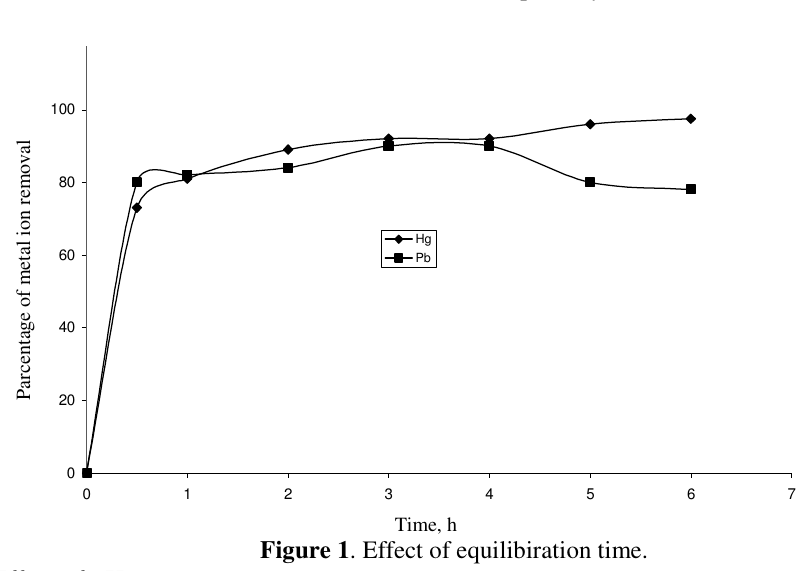
Figure 1 . Effect of equilibiration